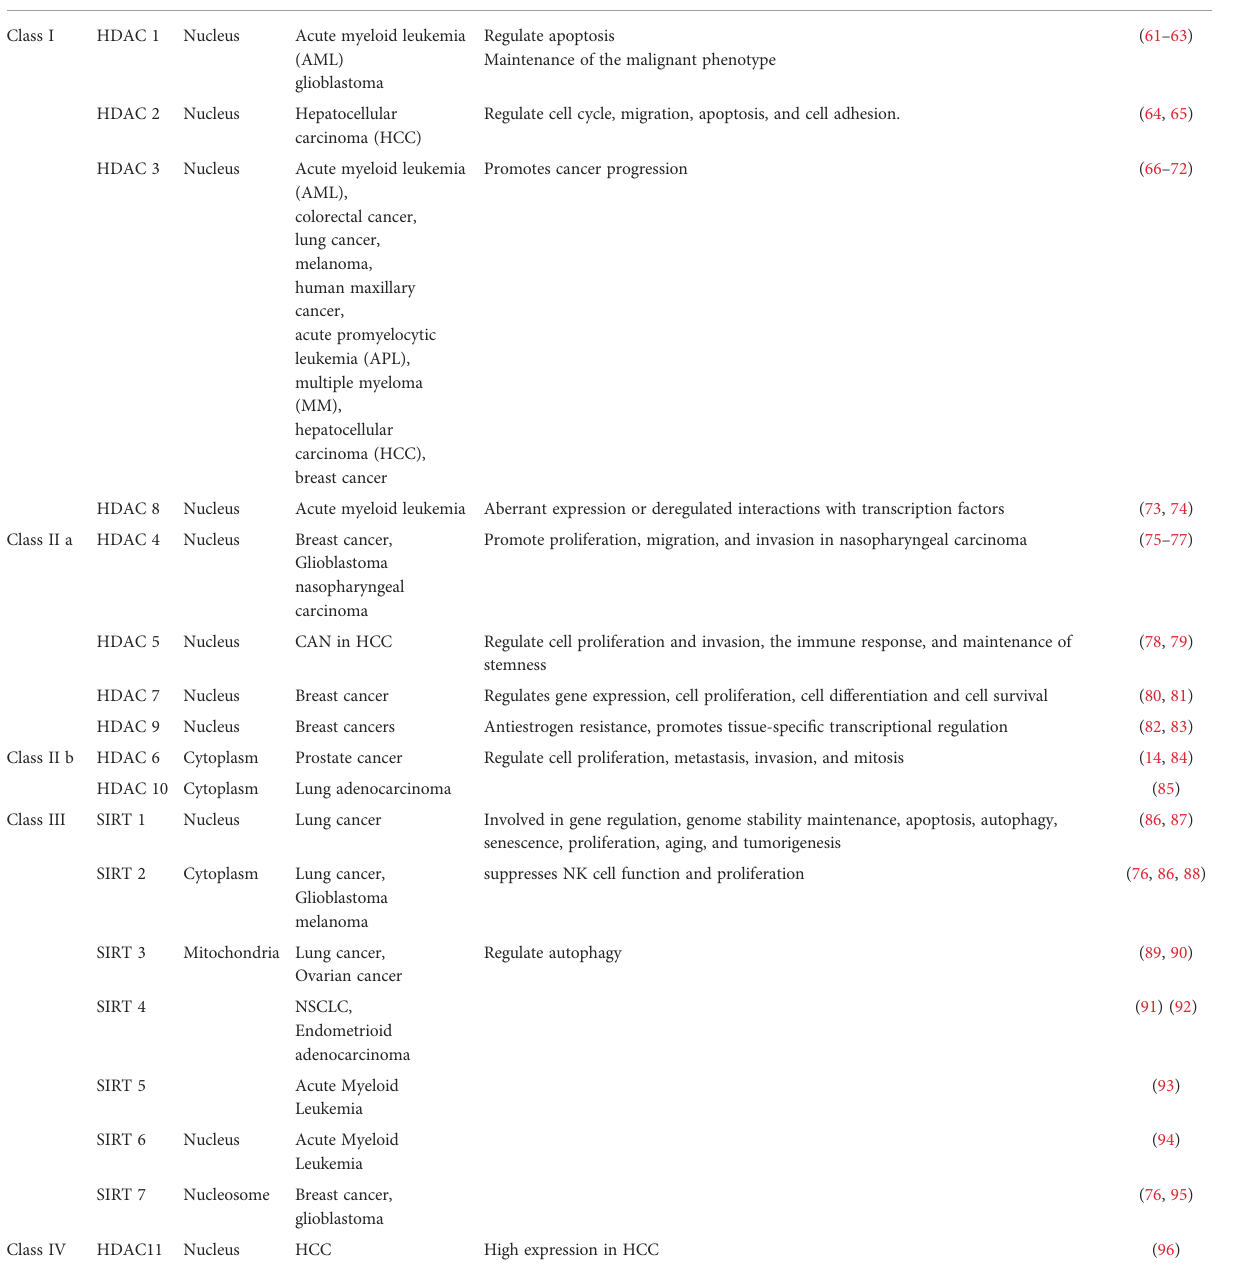
TABLE 2 Classi fi cation, localization and role of deacetylases in cancers.